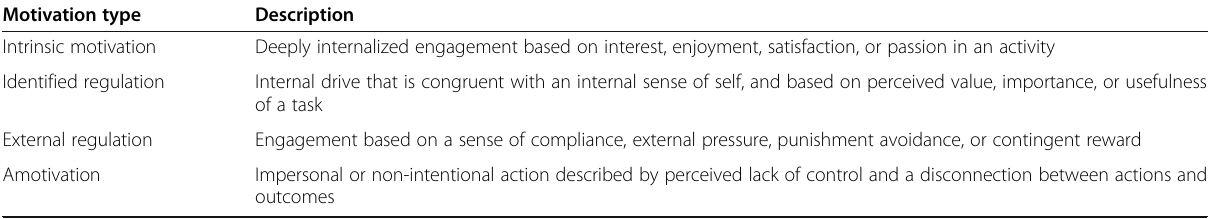
Table 1 Four types of motivation measured by the Situational Motivation Scale (SIMS), ordered from most self-determined (top) to least self-determined (bottom) (Ryan and Deci